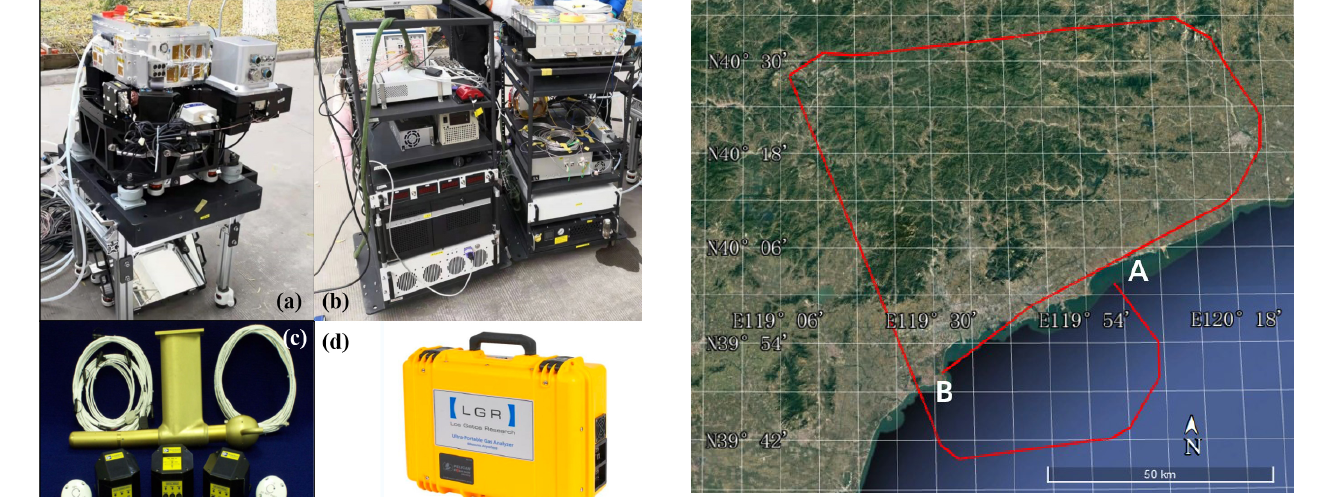
Figure 2. Flight trajectory of the flight on 14 March 2019. The starting point of the flight was at A, and the ending point was at B (© Google Earth